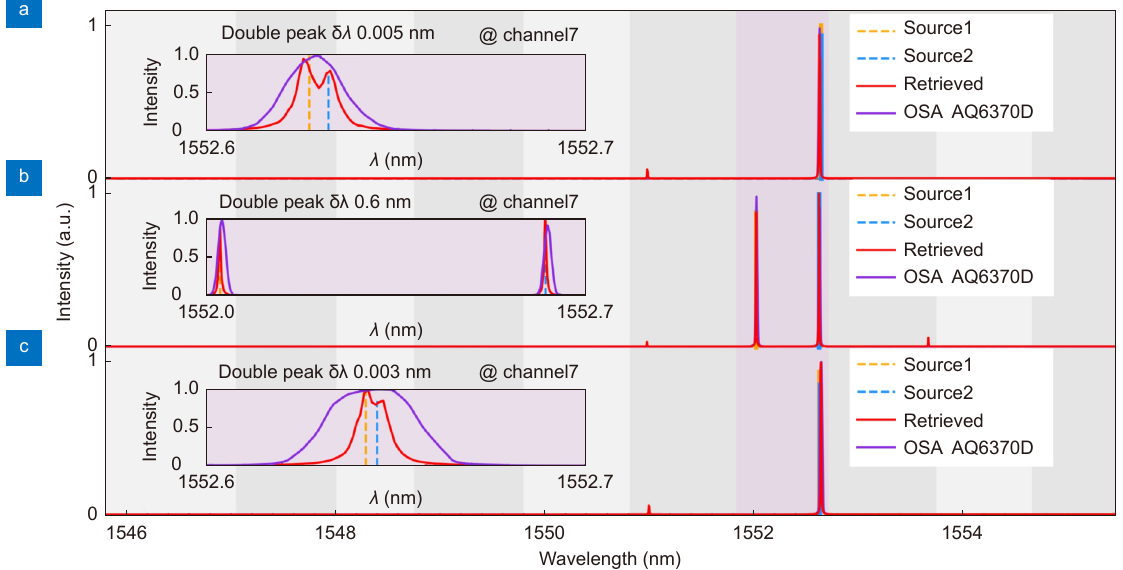
Fig. 5 | Normalized retrieved spectrum with double peak input at channel C 7 . ( a ) (1552.627, 1552.632) nm, ( b ) (1552.024, 1552.624) nm, ( c ) (1552.643, 1552.646) nm.